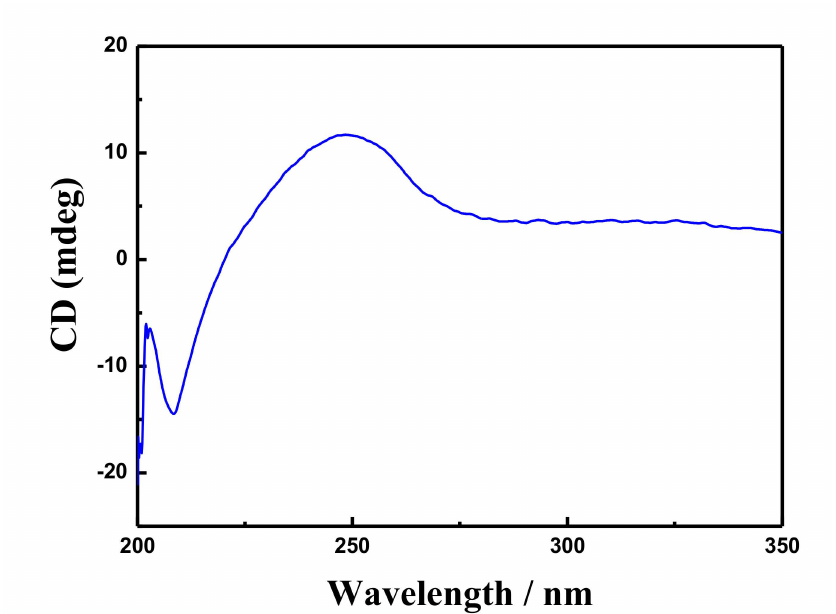
Figure 5. The solid-state circular dichroism (CD) spectra of stochastic of conglomerate 1-H